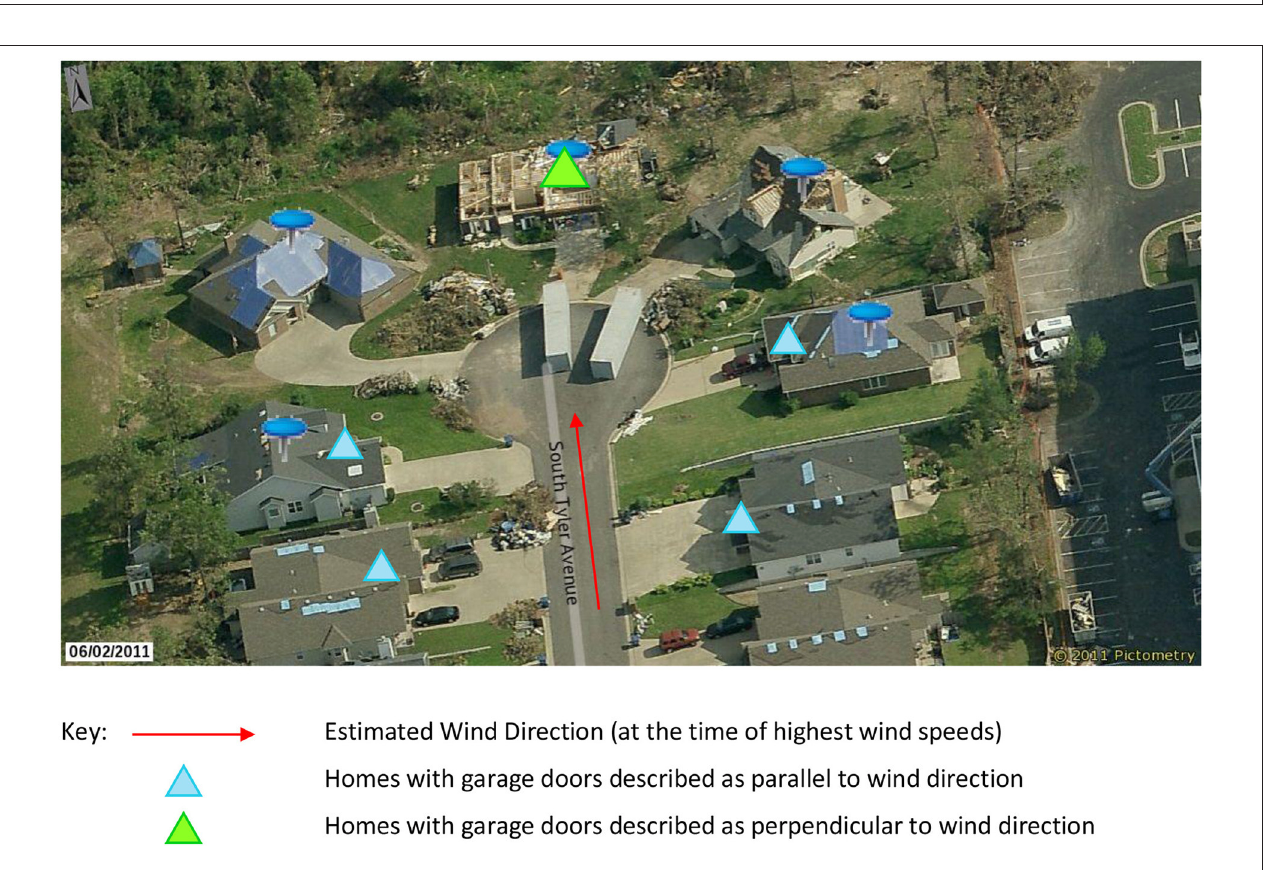
FIGURE 13 | Joplin, MO Cul-de-Sac Damage. Image resolution and quality reduced for publication. Image courtesy of Eagleview Technologies, Inc.